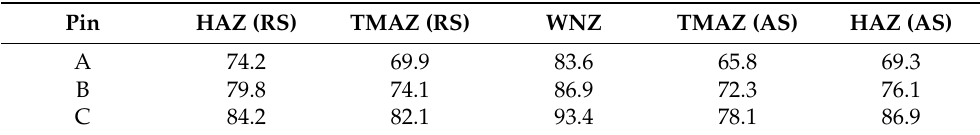
Figure 9. Micro ‐ hardness of joints obtained by different tool pin profiles. Figure 9. Micro-hardness of joints obtained by different tool pin profiles. Table 3. Average microhardness values of different areas of welded joints of three different shapes of pin